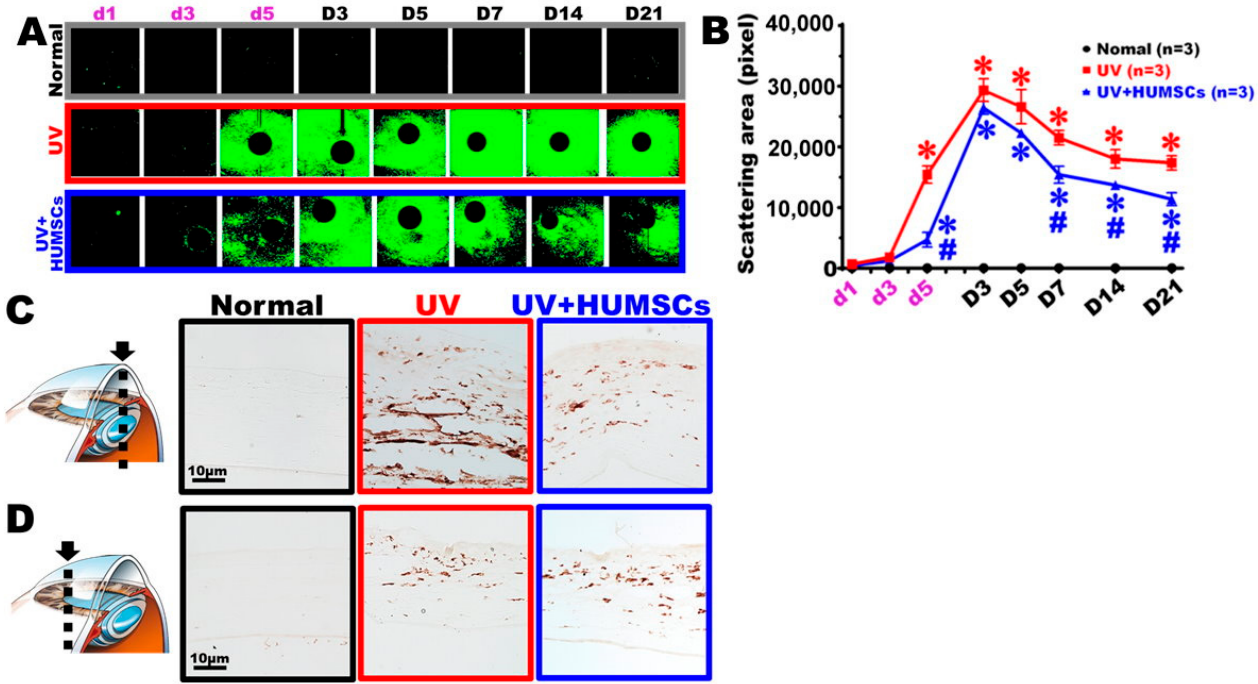
Figure 5. HUMSC transplantation reduces the number of macrophages in the cornea and decreases the light scattering. Multifunction OCT shows the light scattering enface maps ( A ) and the analysis of the scattering area ( B ). Adding stem cells to the cornea can reduce the increase in the light scattering area. Immunohistochemical staining of anti-ED1 was performed to detect activated macrophages in the central ( C ) and peripheral areas ( D ) of the corneas. Strong infiltration of the macrophages was present after UV irradiation, whereas limited activated macrophages were detected in the central area of the corneas in the UV + HUMSC group. The UV + HUMSC group showed significantly fewer macrophages in the corneal stroma. * vs. the Normal group simultaneously, p < 0.05; # vs. the UV group at the same time, p <